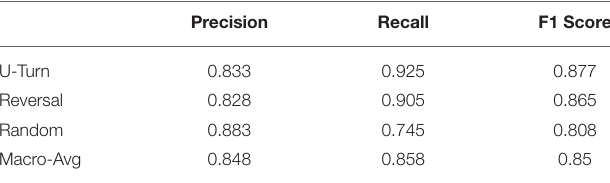
TABLE 3 | Precision, Recall, and F1 Scores of defined behaviors. Precision Recall F1